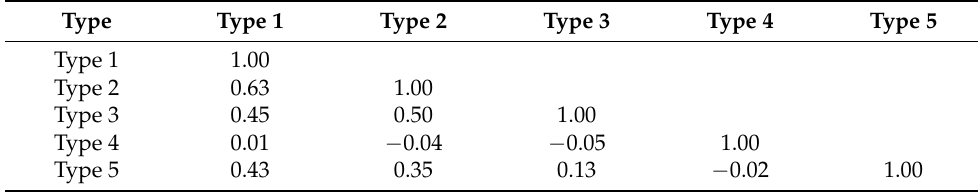
Table 4. Correlations according to